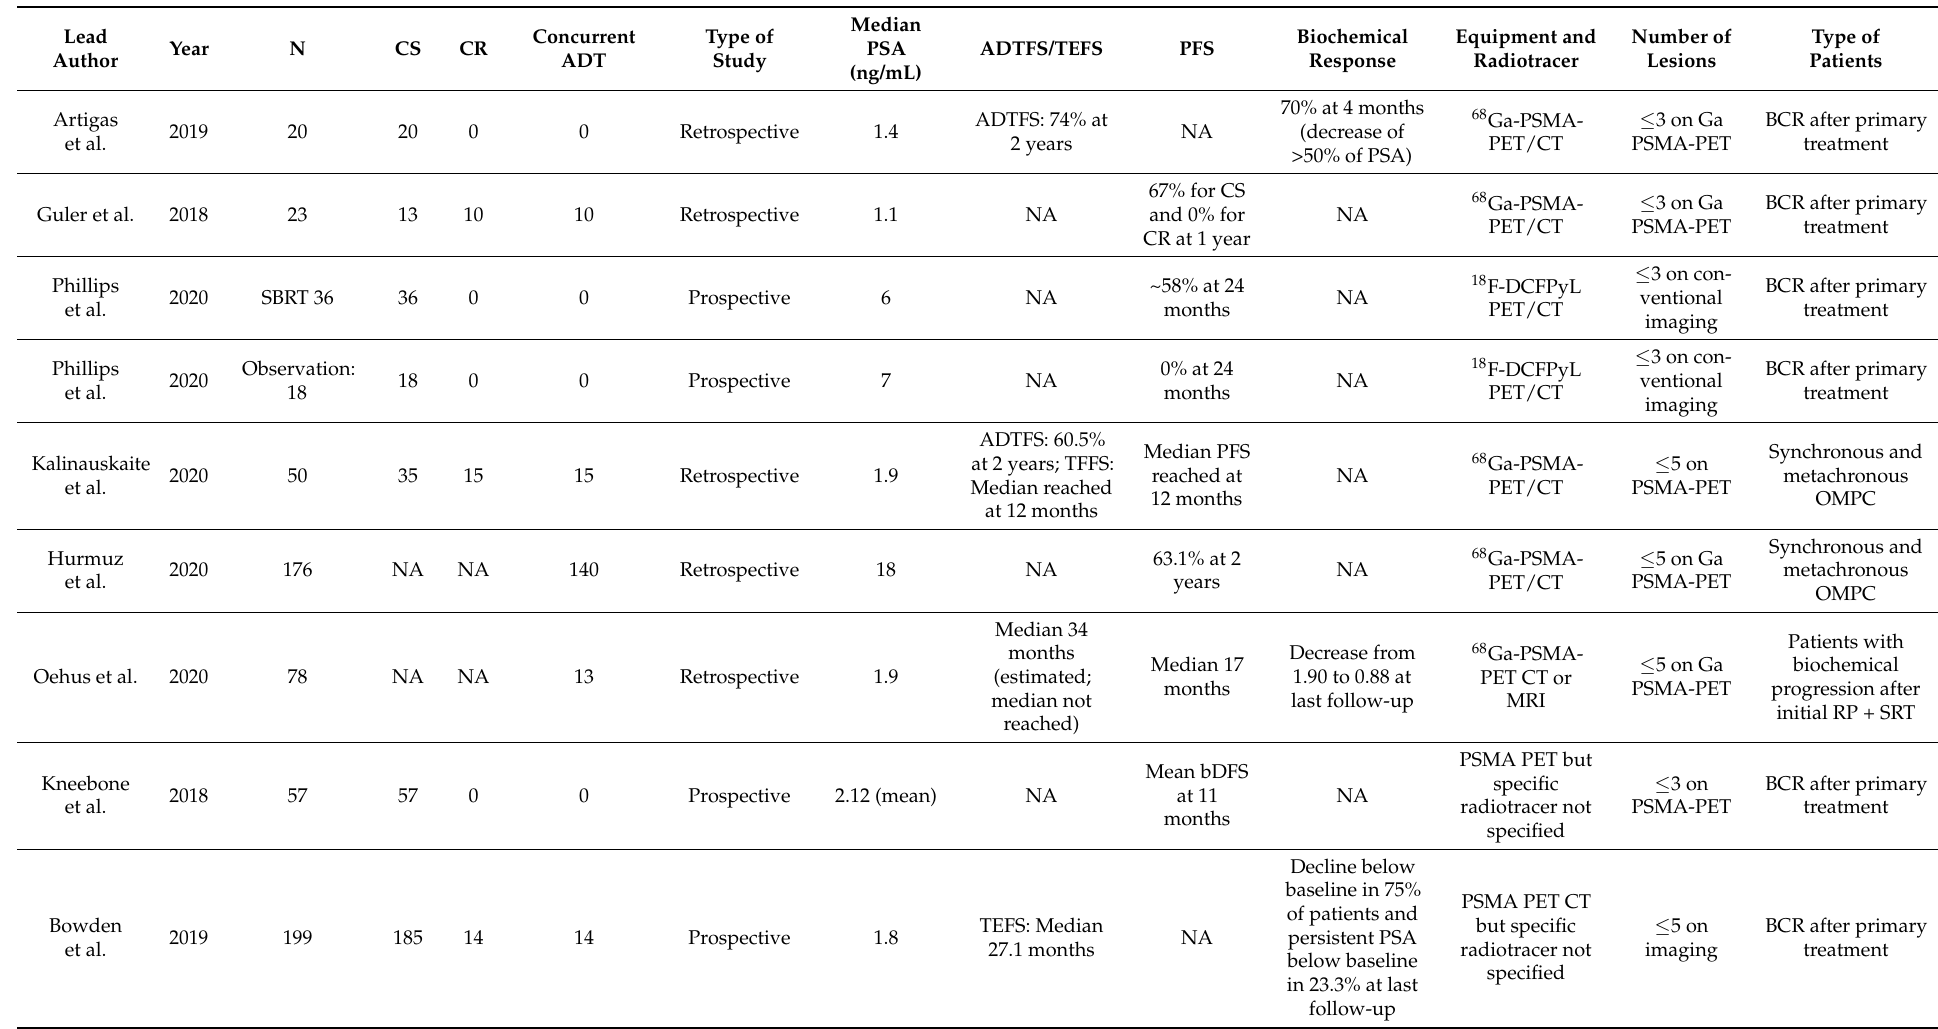
Table 2. Selected studies investigating the use of metastasis-directed therapy in patients with oligometastatic prostate cancer staged with PSMA PET.